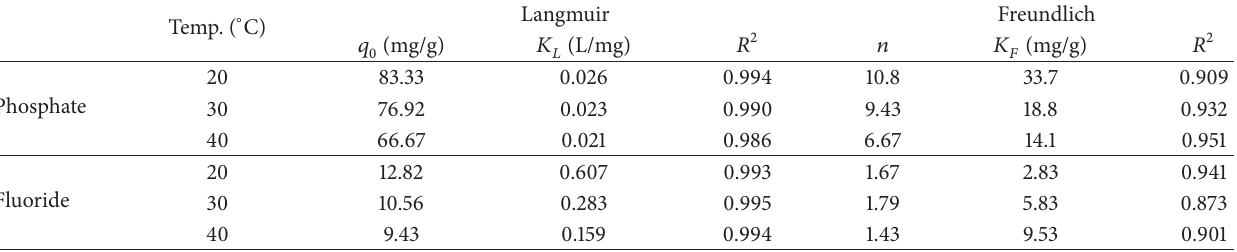
Table 2: Calculated equilibrium constants using the Langmuir and Freundlich equations for phosphate and fluoride adsorption on the LDPO. Temp. ( ∘ C)